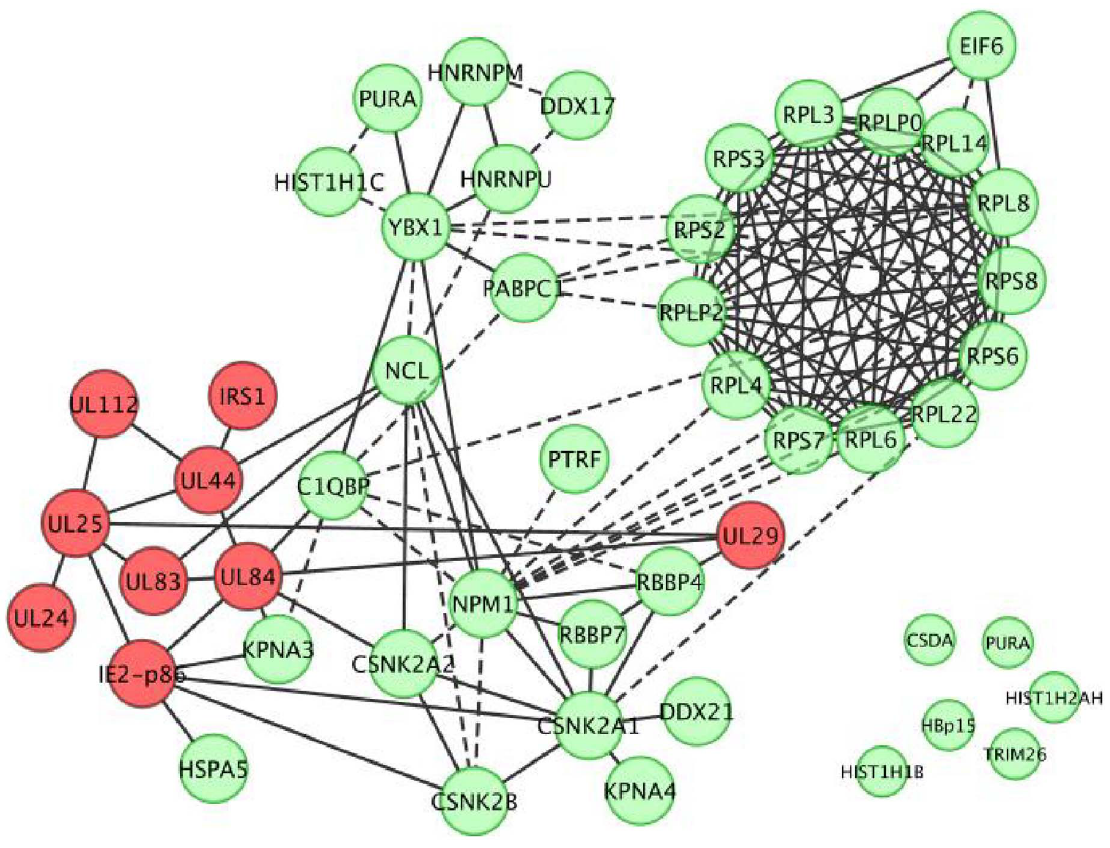
Figure 4. An interaction network of IE2-p86 associated proteins identified in HCMV IE2SG- infected HFF cells. To map the landscape of the IE2-p86 protein interactions, in silico networking analysis of identified proteins in both Table 2 and 3 using STRING database combined with published experimental data were schematically presented by Cytoscape software (version 2.8.3). Solid lines show physical protein–protein interactions based on experimental evidence from published reports and STRING search results. Dashed lines indicate the predicted protein–protein association by STRING database using predictive methods, such as textmining, coexpression, neighborhood, and co-occurance [37]. To simplify the map, only representative ribosomal proteins were